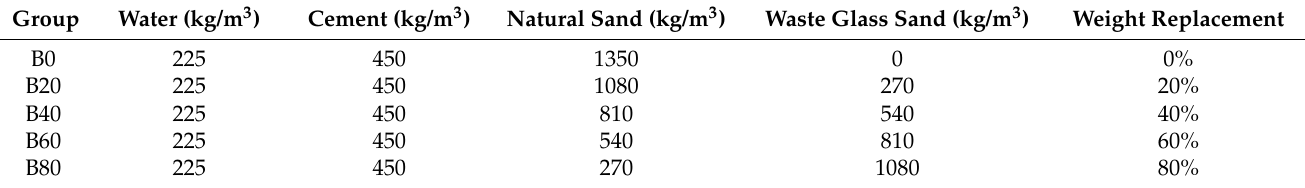
Table 1. Mix proportion of cement mortar.